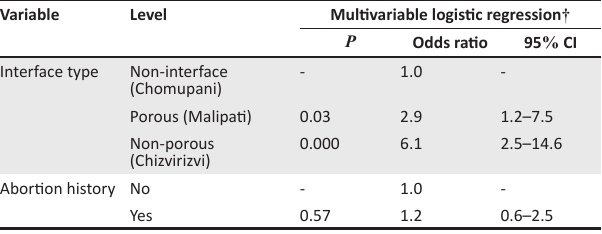
TABLE 4: Survey multivariable logistic regression analysis of the distribution of chlamydiosis seroprevalence according to interface and abortion history of female goats.